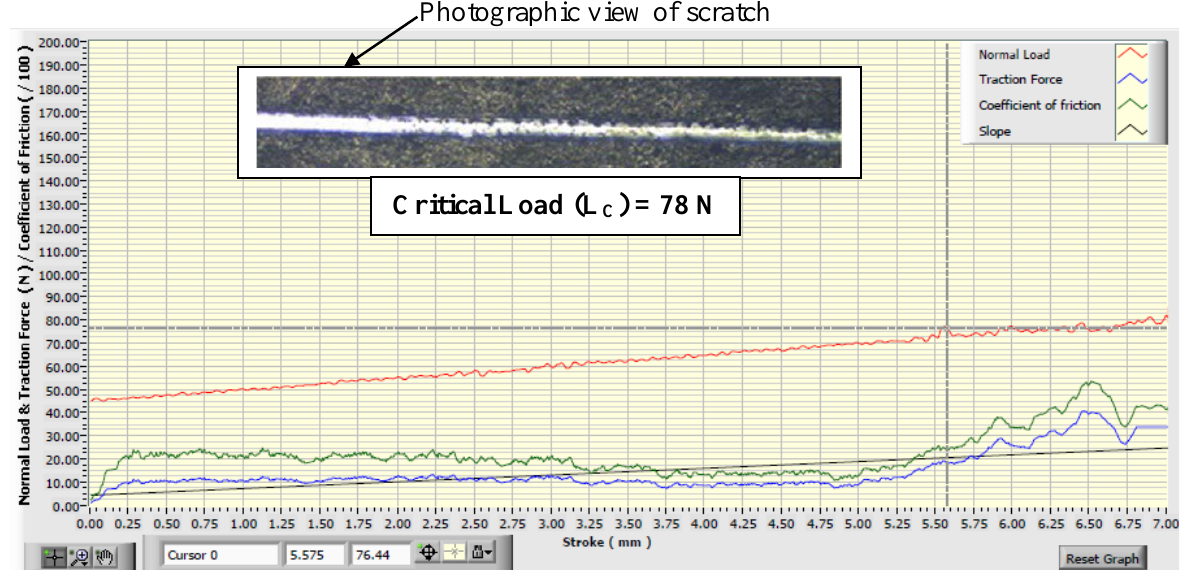
Fig. 3. Variation of normal load and coefficient of friction with scratch length during scratch test on TiAlN coated insert